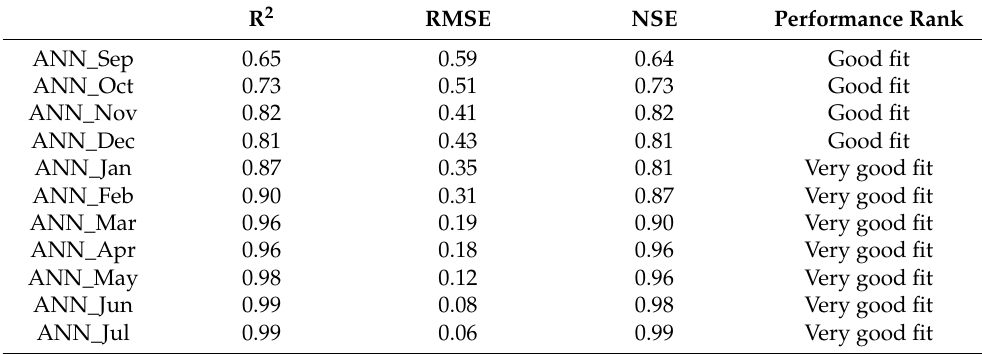
Table 6. Machine learning model performances during the training phase.